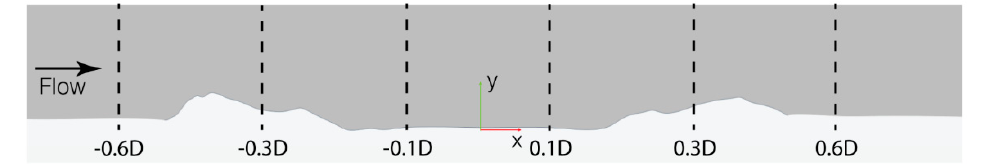
Figure 11. Position of line probes used to obtain vertical profiles across the ridge